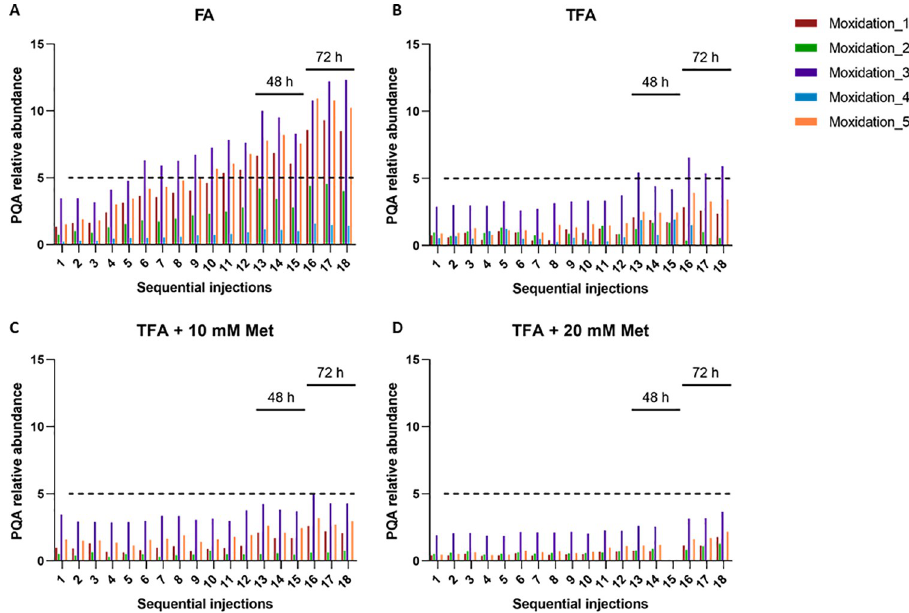
Fig 2. Implementation of the MAM workflow for batch processing analysis using Protein A purified mAb S. Sequential injections (until ~18 h, from injection 1 to 13) of the same sample were done to evaluate the stability of the oxidations at 4˚C. After 48 h (injections 13, 14 and 15) and 72 h (injections 16, 17, 18) the same sample was re- analysed, as indicated in the different graphics of the figure. Different sample preparation protocols were tested: A) Formic acid (FA) was used to stop the trypsin digestion prior to LC-MS analysis; B) Trifluoracetic acid (TFA) was used instead of FA to stop trypsin digestion; C) Methionine at 10 mM was added during the denaturation step; D) Methionine at 20 mM was added during the denaturation